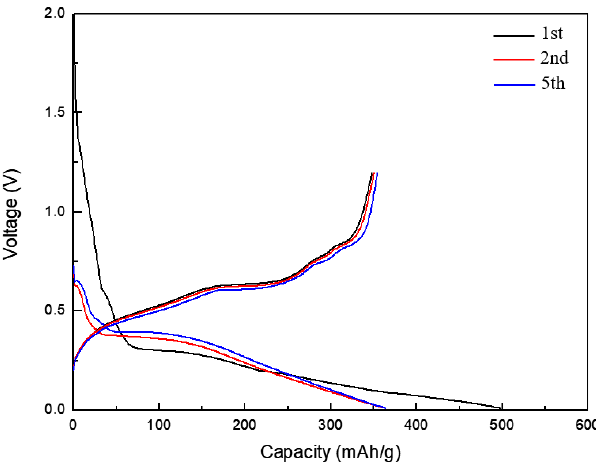
Figure 9. Discharge–charge curve of the TiNi(RT)/Sn/TiNi electrode at 0.5 C in the voltage window of 0.01~1.2 V (vs. Li + /Li).